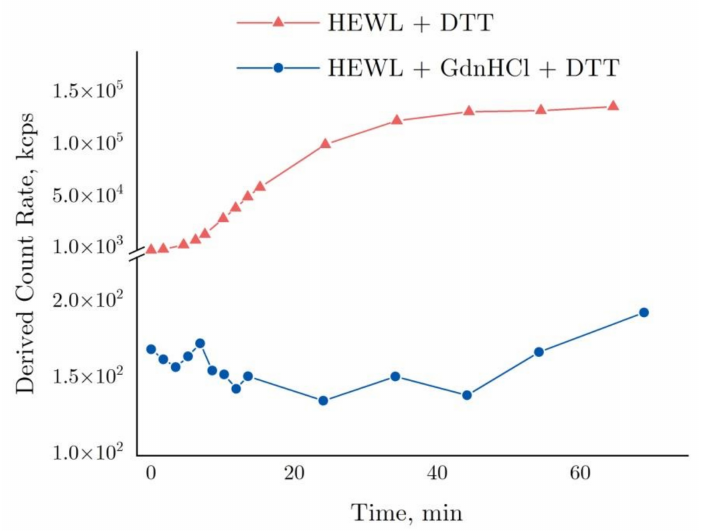
Figure 4. Derived count rate based on DLS data for the denaturation of 4 mg/mL HEWL in 50 mM Tris-HCl (pH = 8.0) with 30 mM DTT or with 6 M GdnHCl and in 30 mM DTT.